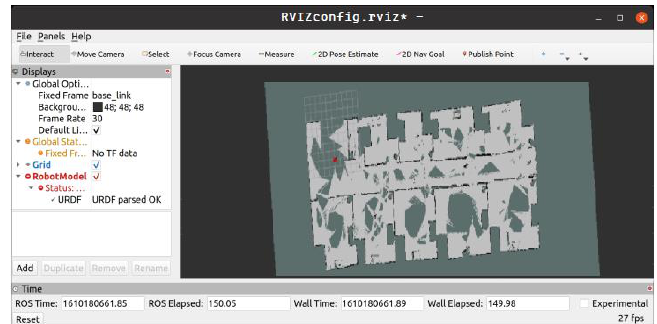
Figure 3. RVIZ main screen. This tool allows a 3D visualization for ROS applications.